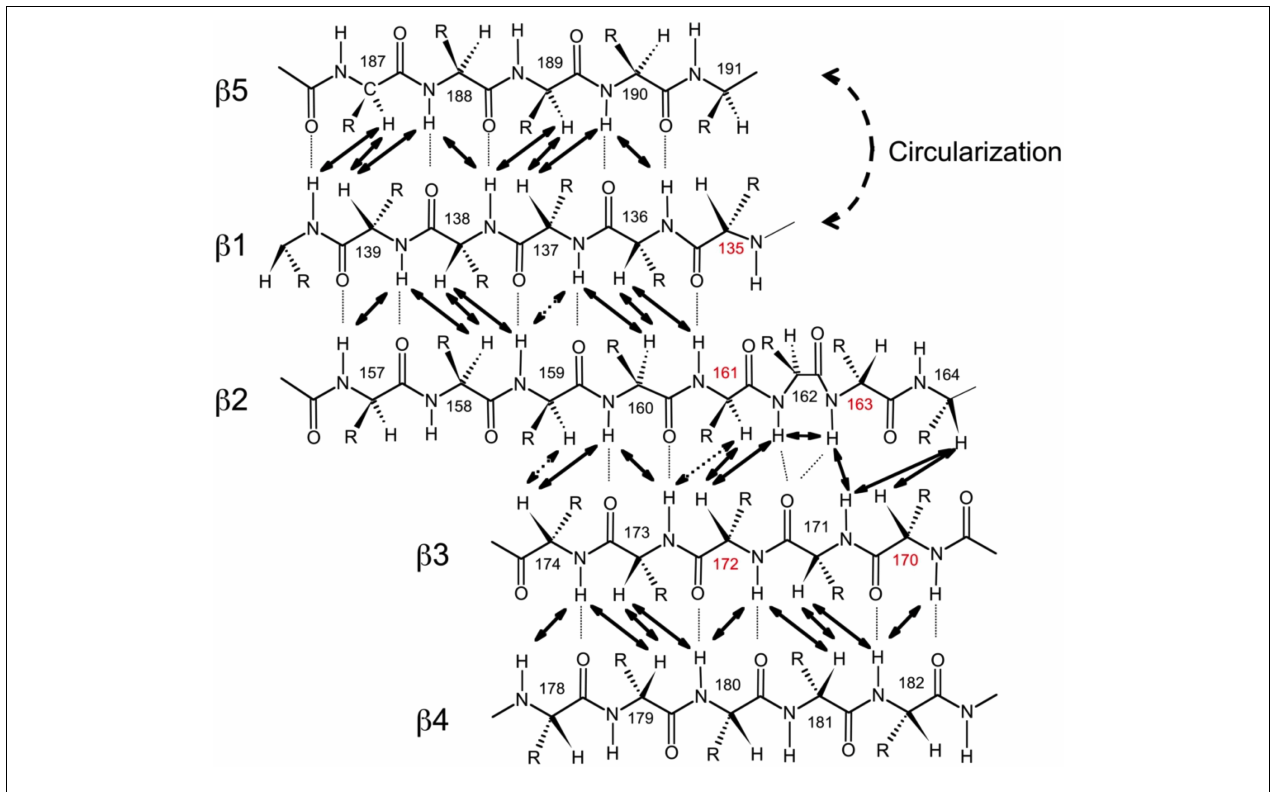
FIGURE 3 | Alignment of the β -strands in the SH3 domain based on the observed NOE contacts. Arrows indicate pairs of hydrogen atoms for which NOESY cross peaks were observed. Based on the characteristic patterns of close inter-proton distances, hydrogen bonds (dotted lines)